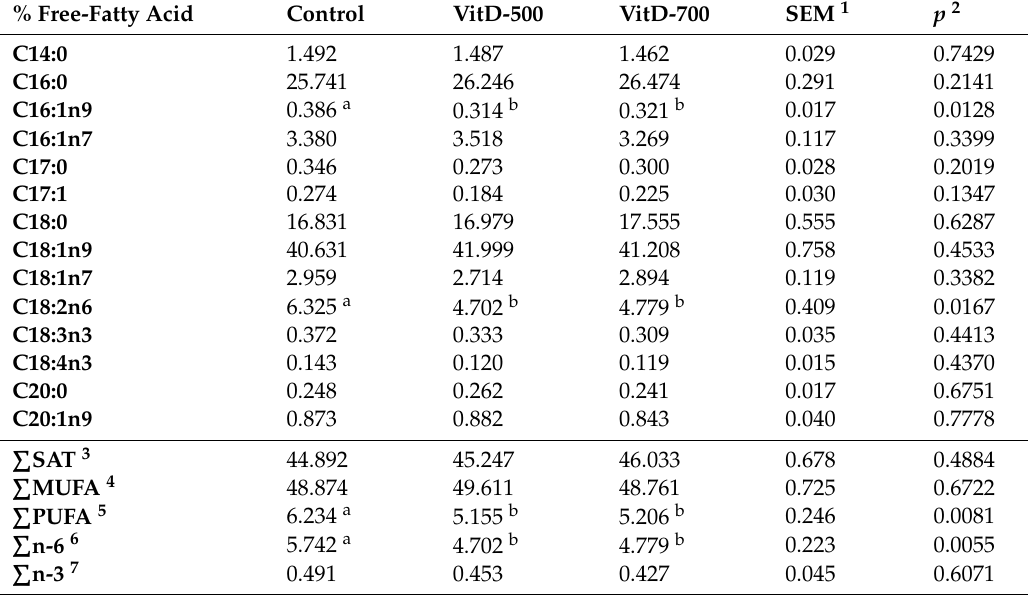
Table 5. Free-fatty acid proportion (g / 100 g fatty acids) in muscle from pigs supplemented with vitamin D 3 at di ff erent doses (500,000 UI / l vs. 700,000 UI / l) or without supplementation prior to slaughter (experiment 2).